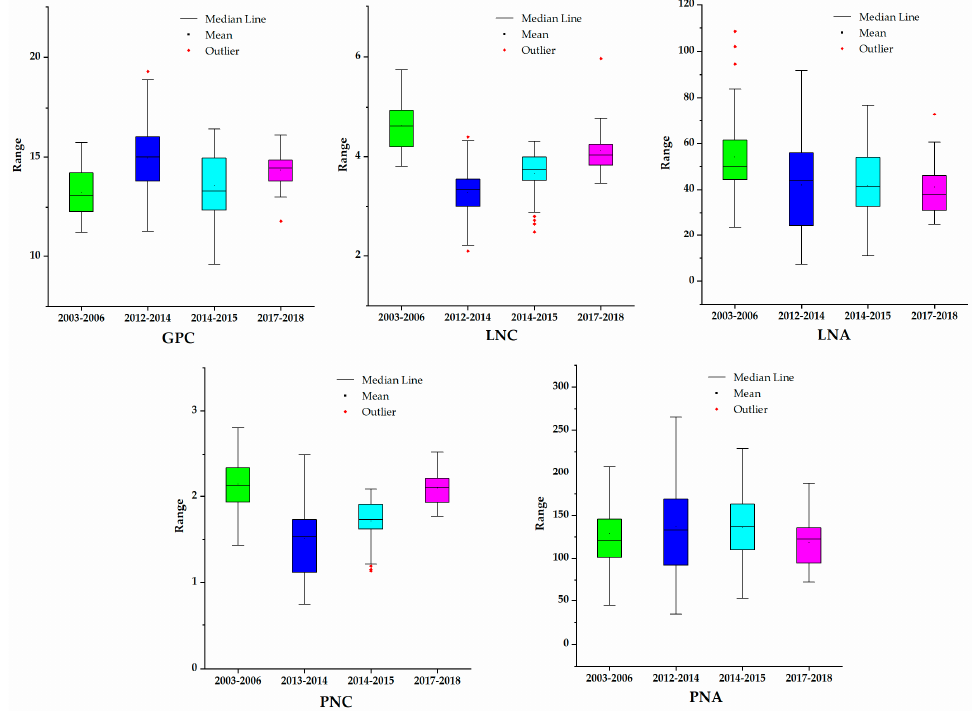
Figure 5. The distribution of the measured data.